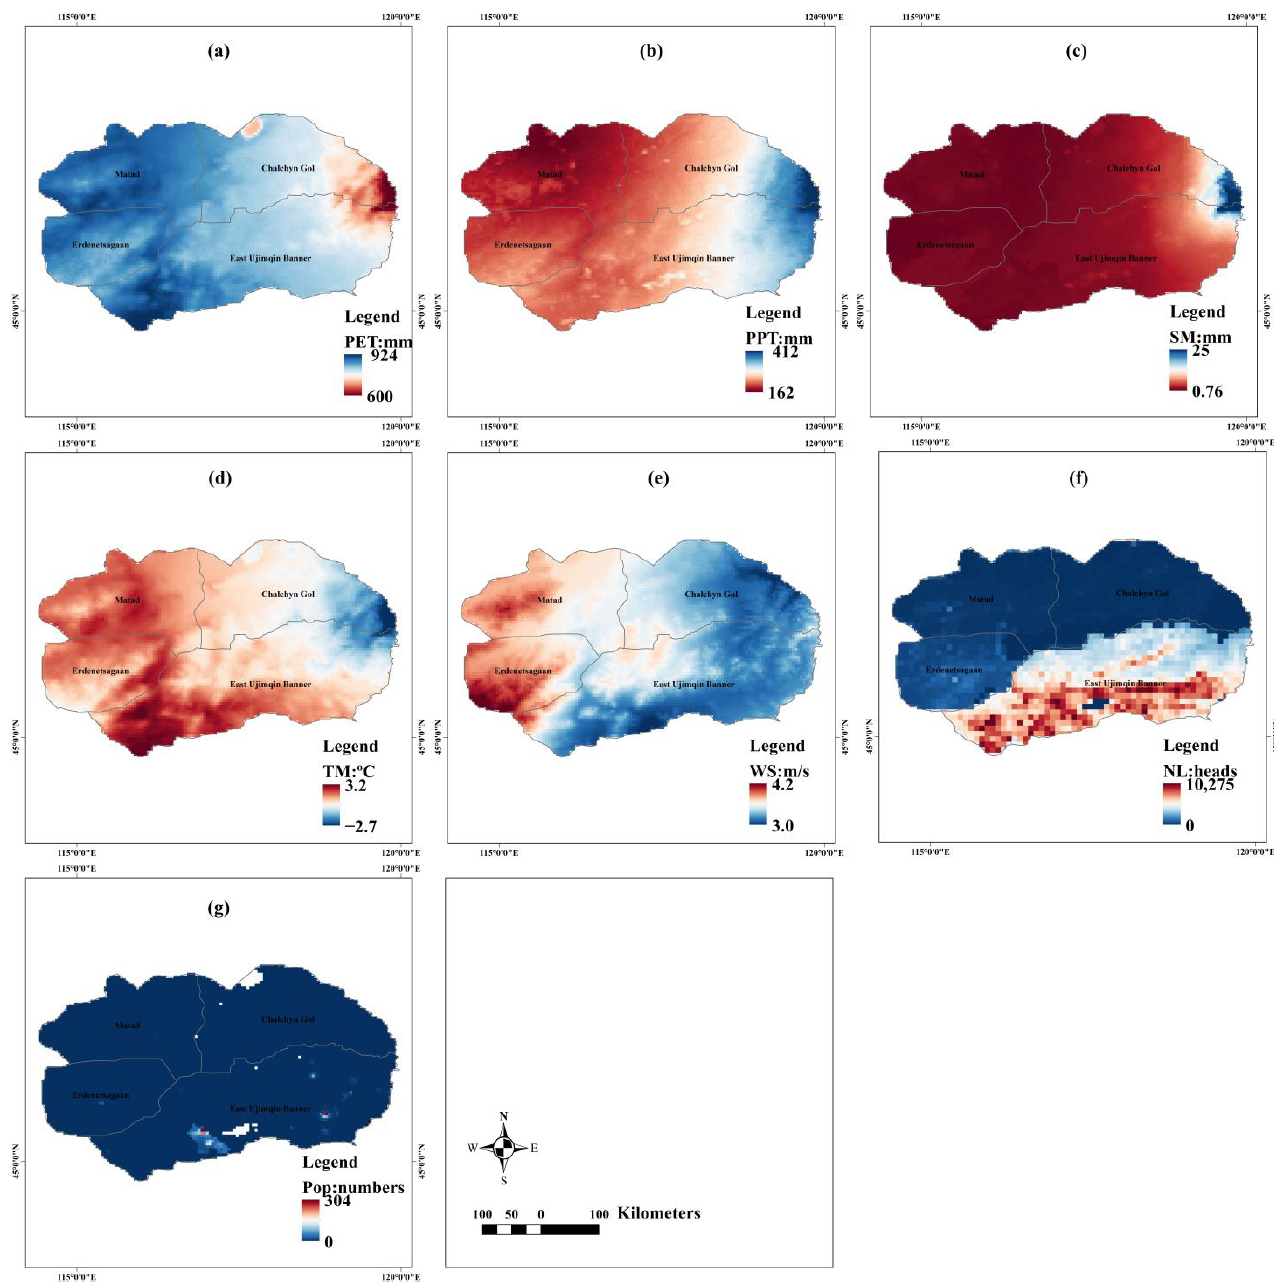
Figure 9. Spatial distribution of desertification drivers in the study area. ( a ) Potential evapotranspiration; ( b ) precipitation; ( c ) soil moisture; ( d ) temperature; ( e ) wind speed; ( f ) number of livestock; ( g ) population.